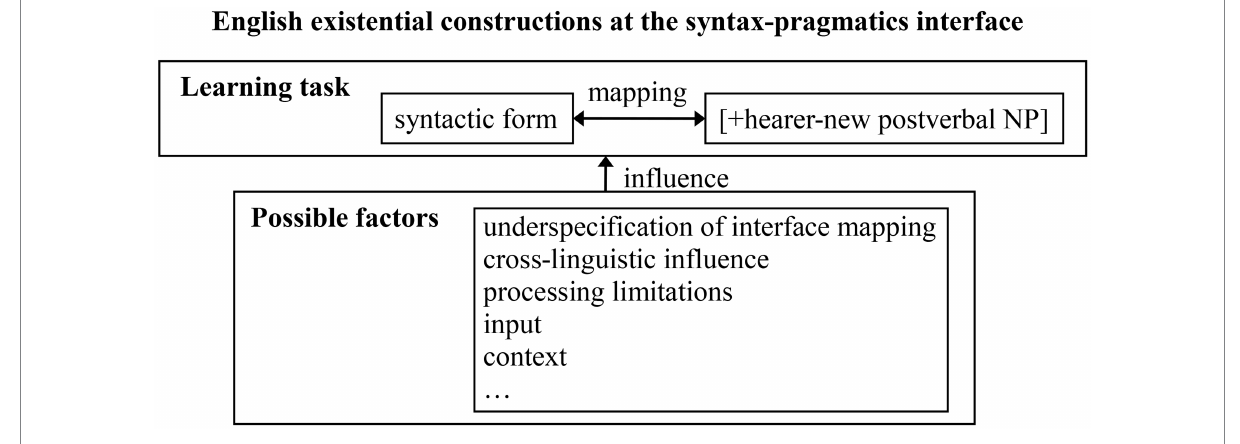
FIGURE 1 English existential constructions at the syntax – pragmatics